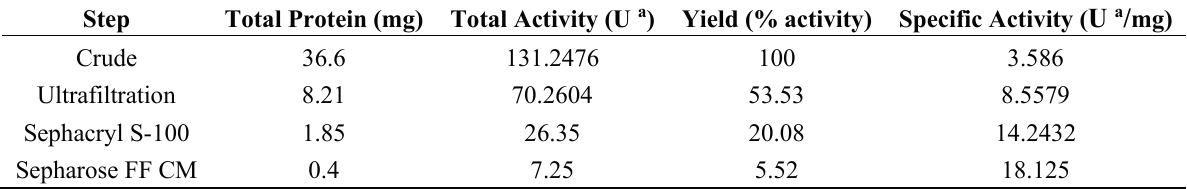
Table 1. Purification of PGC3 from culture of FOC4 grown on potato dextrose broth (PDB) supplemented with 1% citrus